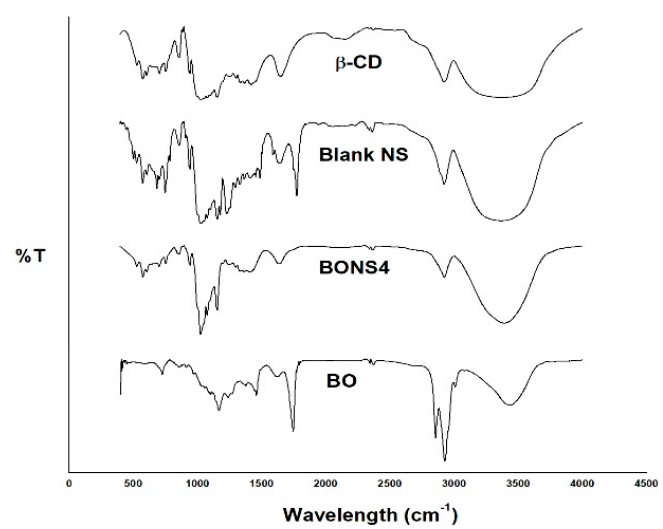
Figure 3. FTIR spectra of BO, β -CD, blank NS, and BONS4.